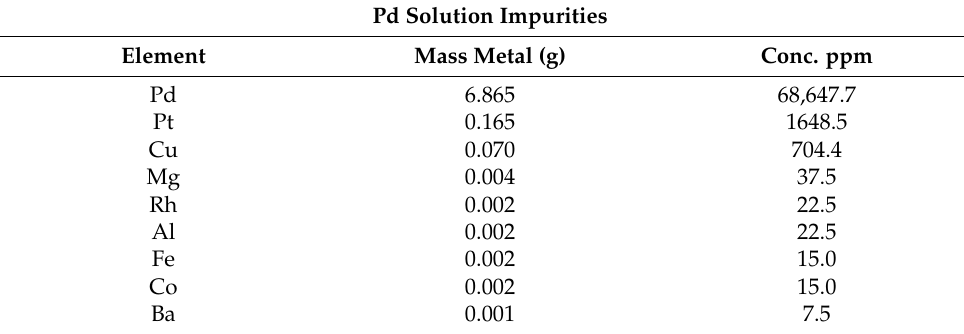
Table 6. ICP analysis of Pd sample and the impurities